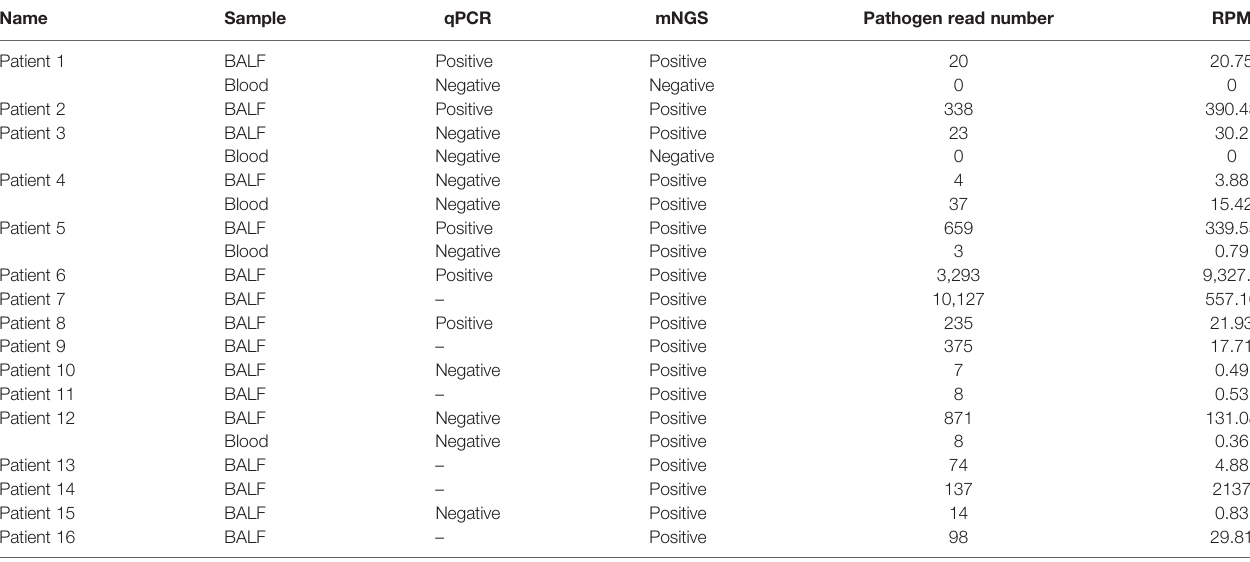
TABLE 1 | The mNGS and qPCR results of all